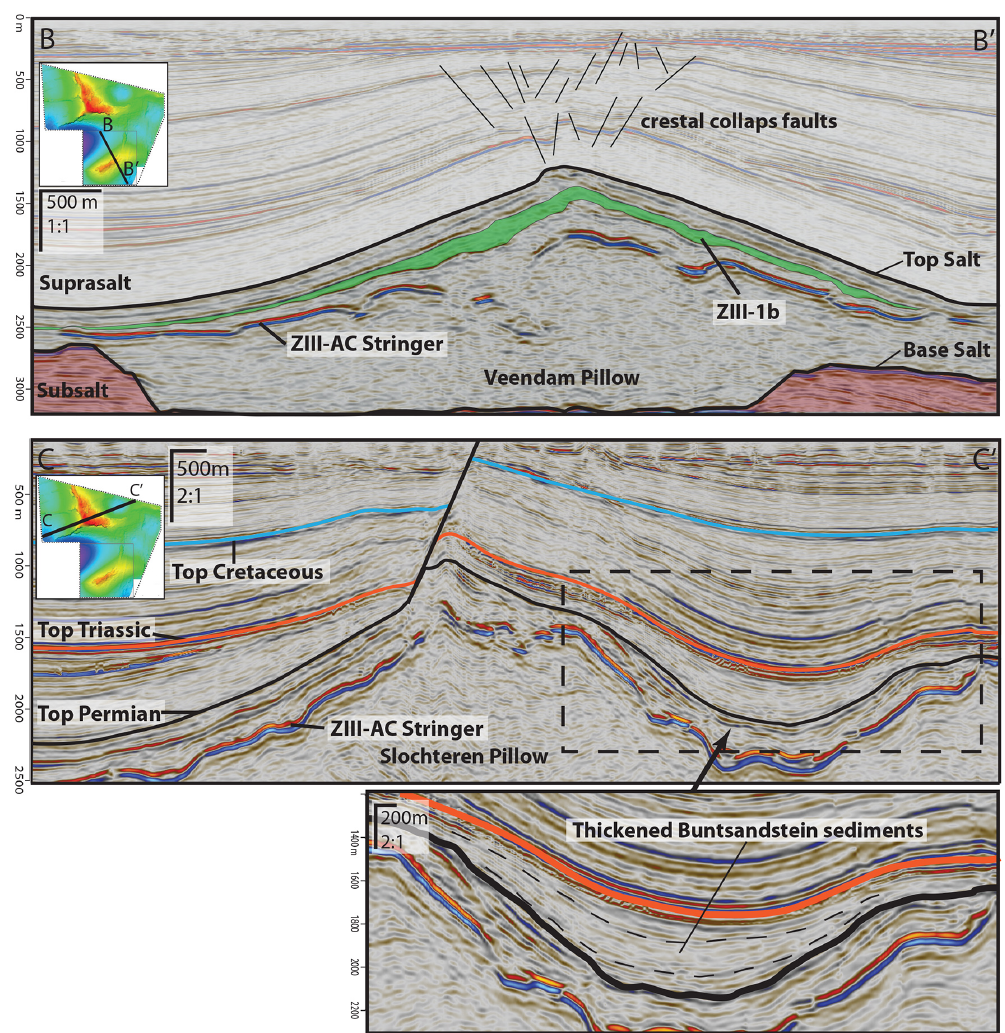
Figure 3. Top: NWN–SES profile through the Veendam Pillow showing thickening of the ZIII-1b (green) above the AC-stringer synclines and crestal collapse grabens above the pillow. Bottom: ESE–WNW profile through the Slochteren Pillow. Enhanced area is showing thickening of the Triassic towards the basin